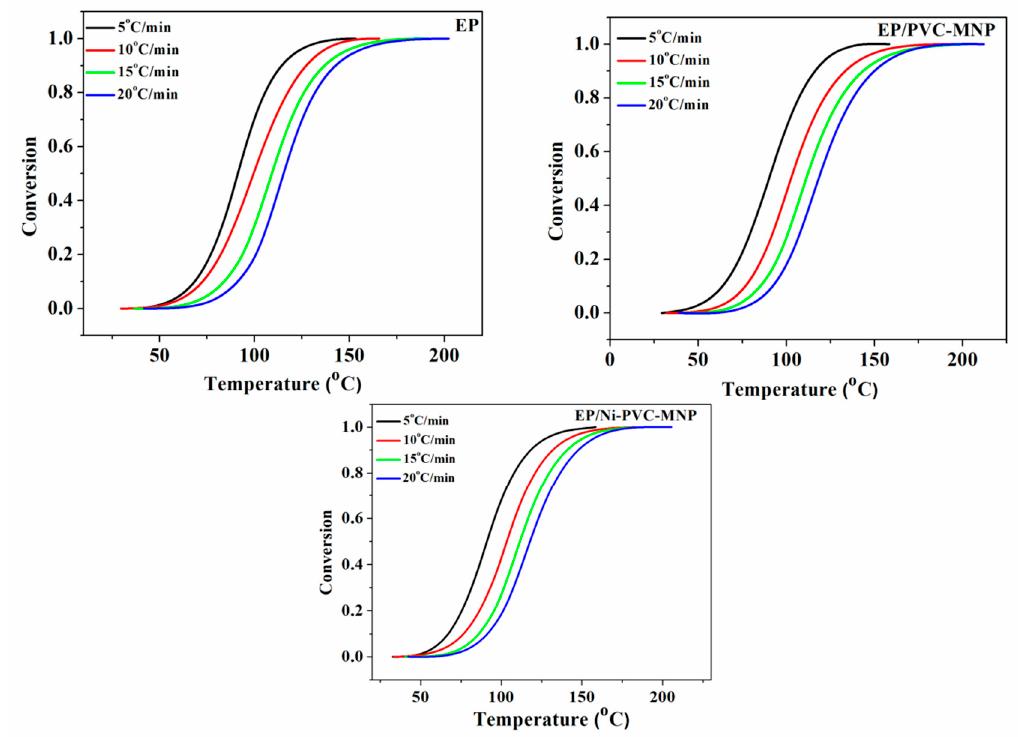
Figure 7. Variation of α as a function of reaction temperature for the EP (the reference sample) [50,51], EP/PVC–MNP and EP/Ni–PVC–MNP nanocomposites at heating rates of 5, 10, 15 and 20 °C/min.